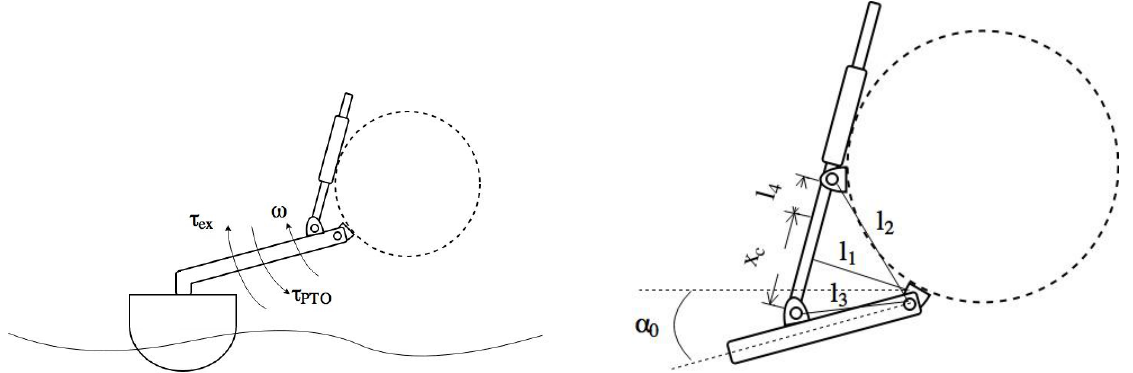
Figure 2. The geometry of the Wavestar